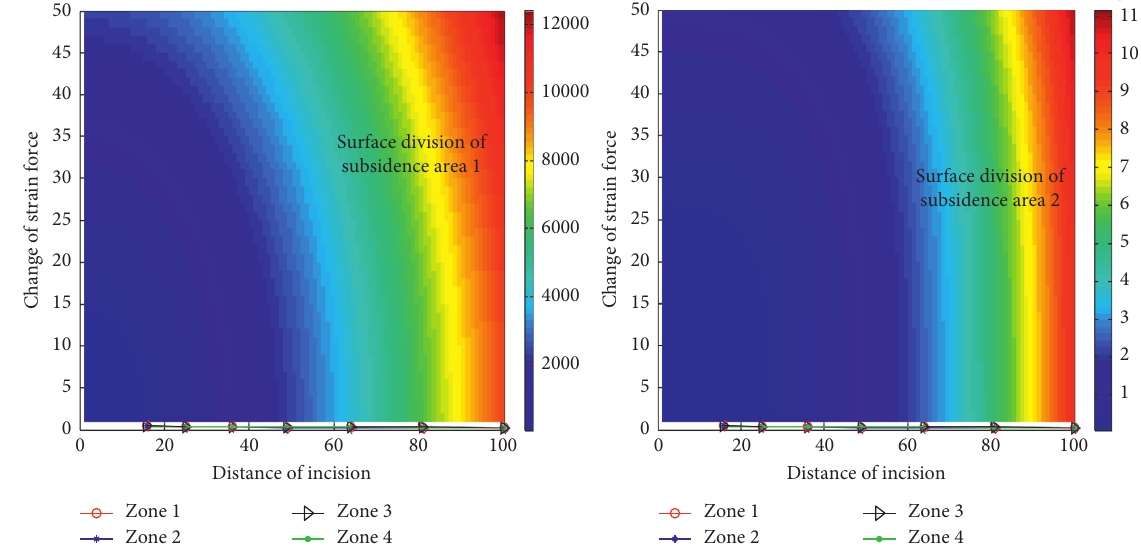
Figure 8: Treatment map of distance between surface working face and cut hole in subsidence area ( d � 50 cm).